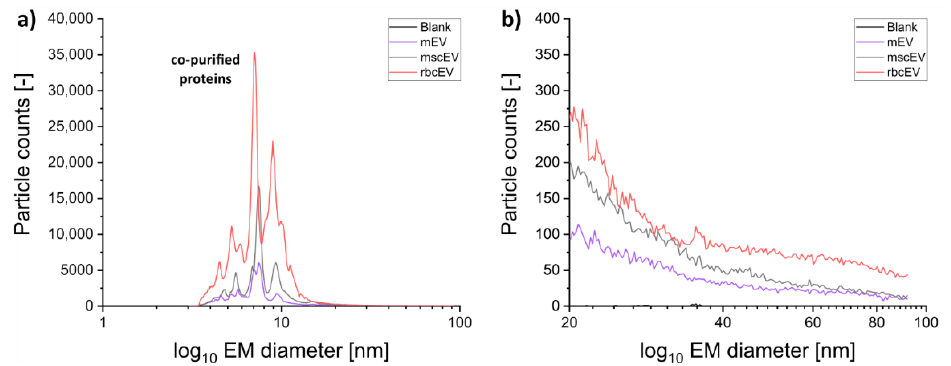
Figure 3. Characterization of EVs deriving from different cell types (mEV, mscEV, and rbcEV) and their surface-dry particle size distribution via nES GEMMA. The EV isolates reveal differences in the lower nm range in terms of detected particle numbers (co-purified proteins, ( a )) in comparison to the upper nm range ( b ). There, changes in particle numbers are significantly less pronounced.